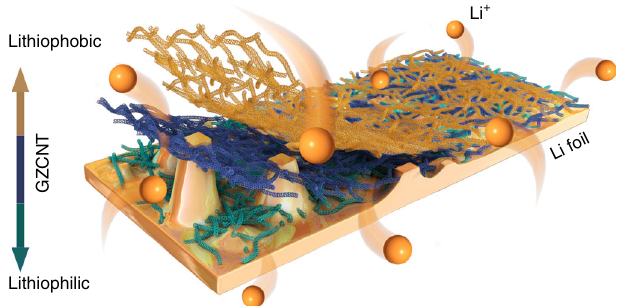
Fig. 1 Schematic diagram for Li deposition of Li foils coated with a GZCNT interfacial layer. The bottom lithiophilic part of the GZCNT layer anchored onto the Li foil and effectively ensured even Li plating by